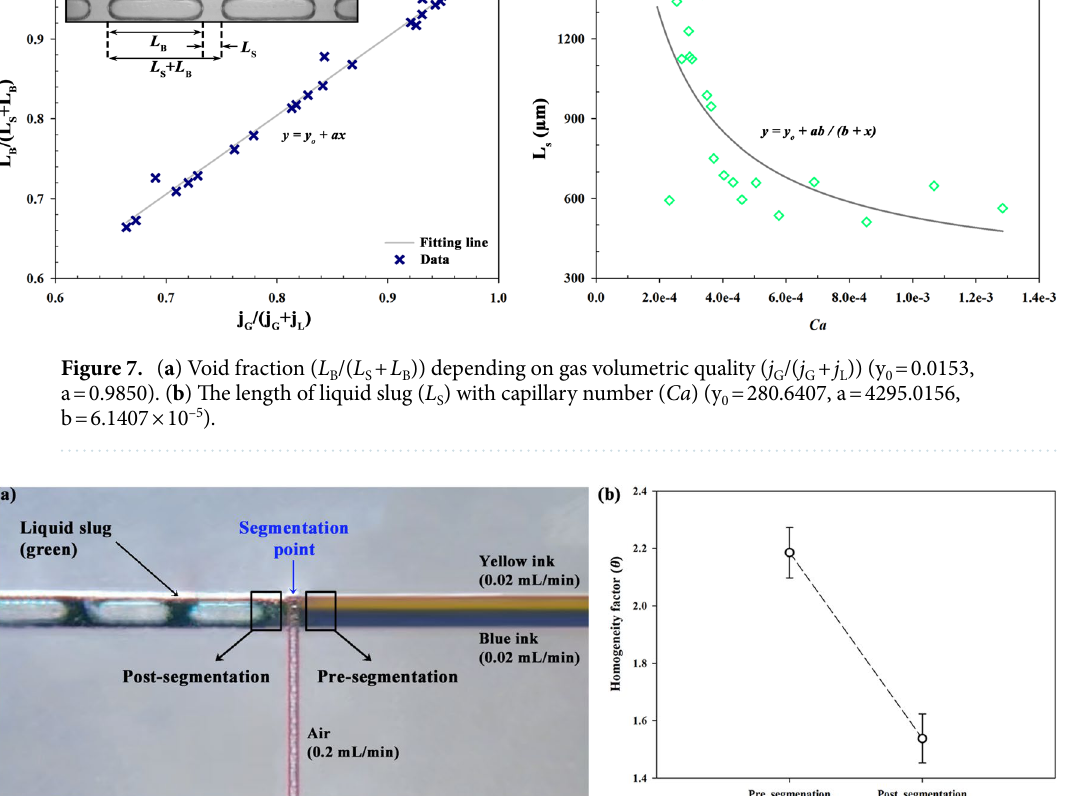
Figure 8. ( a ) Segmented flow in 3D-printed mixing chip ( b ) Homogeneity factor ( θ ) at pre- and post-